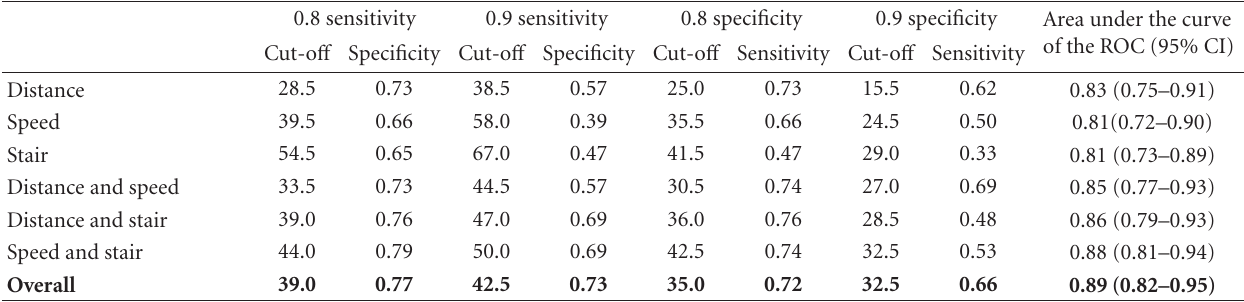
Table 4: Cut-o ff s for the WIQ subscores and combined scores for various sensitivity and specificities as well as the area under the curve of the ROC for identifying those in the low walking performance group.